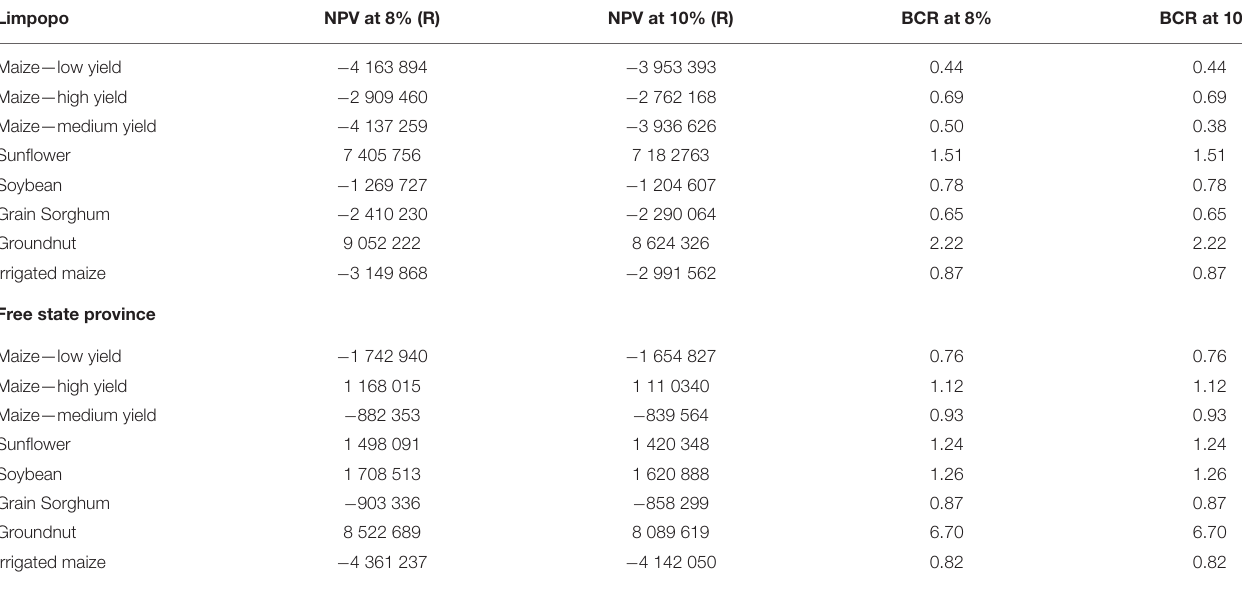
TABLE 5 | Net Present Value and Benefit Cost Ratio for selected crops in Limpopo and Free State.